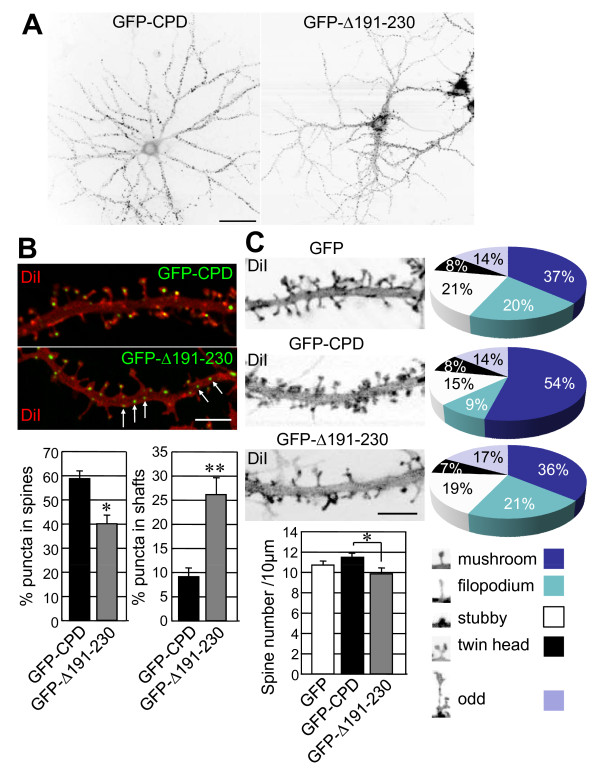
Deletion of the Cupidin Cdc42-binding domain influences dendritic spine morphology in hippocampal neurons. (A) GFP fluorescence images of primary cultured rat hippocampal neurons infected with the recombinant adenovirus vector containing GFP-CPD or GFP-CPDΔ191–230 (= GFP-Δ191–230). (B) Dendrites expressing GFP-CPD or GFP-CPDΔ191–230 (= GFP-Δ191–230) fluorescence (green) were outlined by staining with DiI (red). White arrows indicate representative puncta of GFP-CPDΔ191–230 (= GFP-Δ191–230) located in dendritic shafts. The ratios of puncta present in either spine heads or dendritic shafts per total puncta in dendrites were quantified. *, p < 0.01; * *, p < 0.001. (C) Spine morphologies of neurons expressing GFP, GFP-CPD, or GFP-CPDΔ191–230 (= GFP-Δ191–230) were arbitrarily categorized into five types (mushroom-, filopodium-, stubby-, twin head-, and odd-shaped types) as indicated in the inset; each population (%) is shown in the pie charts. The graph shows the number of spines present in a 10-μm length of secondary dendrites of these neurons. *, p < 0.05. Bars: (A) 20 μm, (B and C) 5 μm.